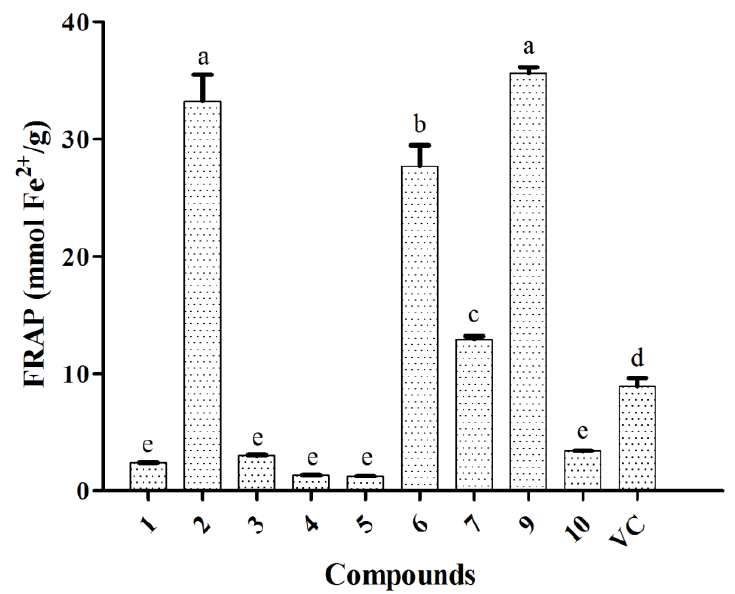
Figure 5. Total antioxidant activities of compounds 1 − 7 and 9 − 10 by FRAP assays. VC was used as positive control. Compound 8 did not show any activities in FRAP assay. Data are expressed as means ± SD ( n = 3). Means labeled by different letters (a – e) were significantly different at a level of p < 0.05 ( n = 3) by One-Way ANOVA